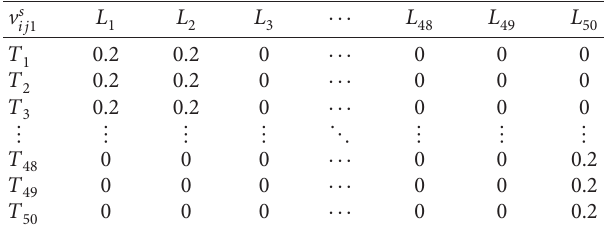
Table 10: Normative profit and loss matrix F landlords’ housing location.